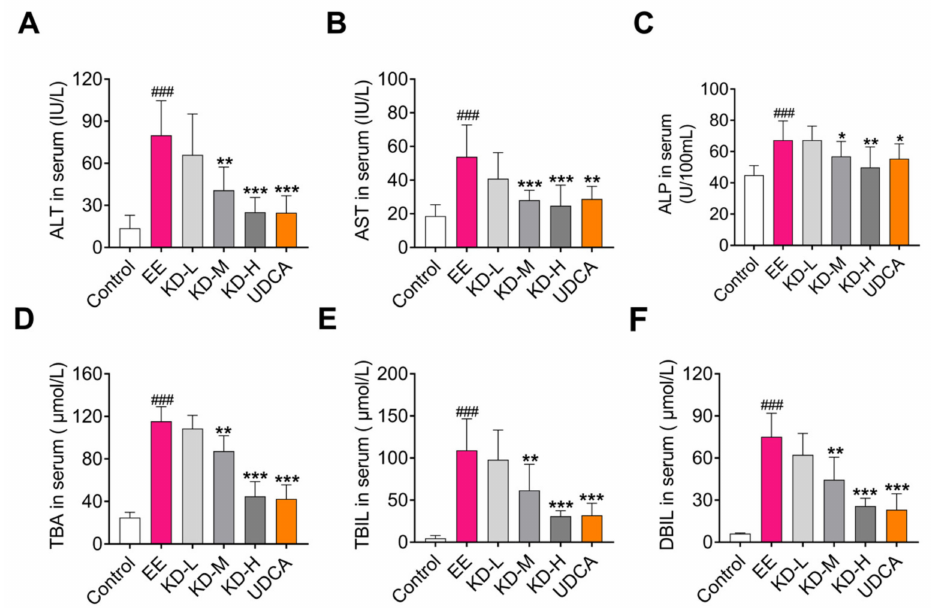
Figure 2. The effects of KD on serum biochemical factors associated with EE-induced cholestasis in rats. Serum ( A ) alanine aminotransferase (ALT), ( B ) aspartate aminotransferase (AST), ( C ) alkaline phosphatase (ALP), ( D ) total bile acids (TBA), ( E ) total bilirubin (TBIL) and ( F ) direct bilirubin (DBIL) levels in each group were determined by commercial kits. Data are presented as mean ± SD ( n = 10). ### p < 0.001 denotes statistical significance, compared to the control group. * p < 0.05, ** p < 0.01 and *** p < 0.001 denote statistical significance, compared to the EE